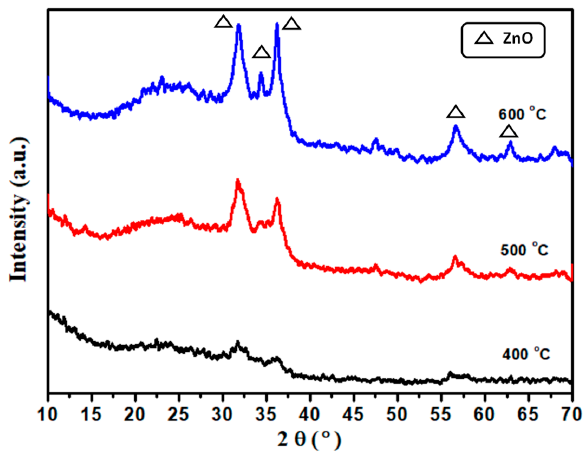
Figure 3. XRD analysis of ZnO samples.